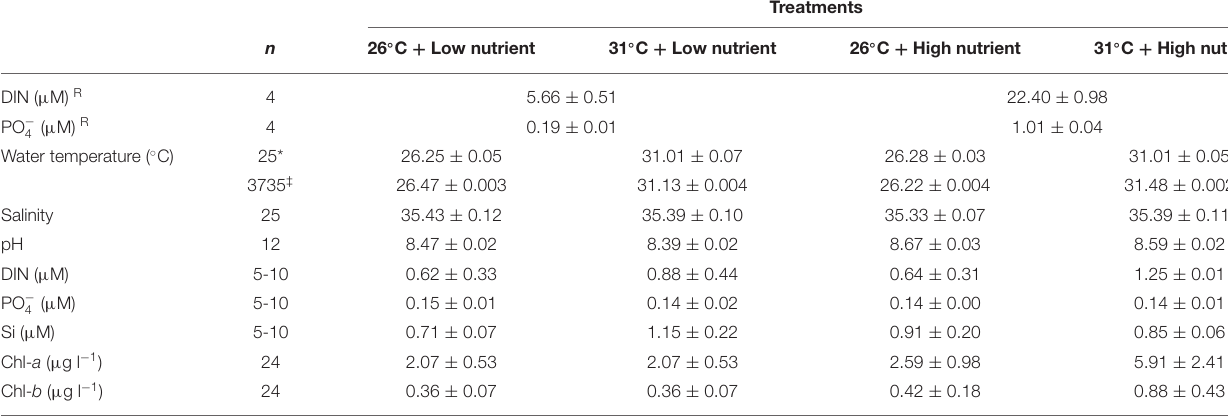
TABLE 1 | Experimental water quality